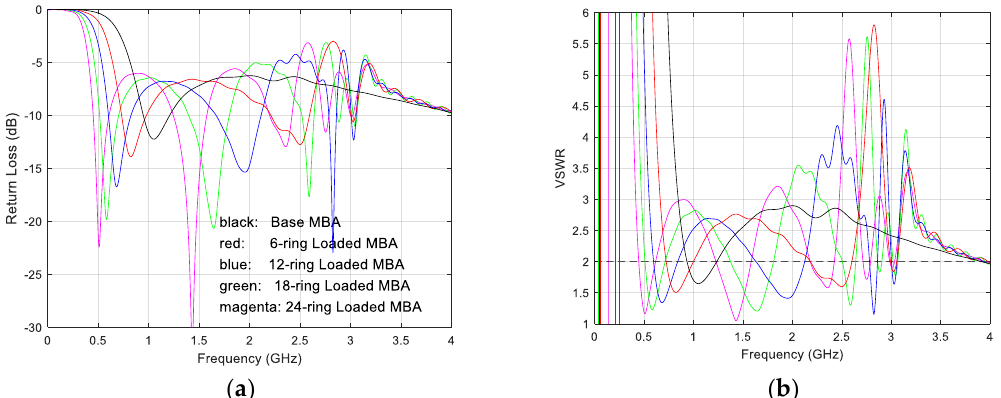
Figure 16. ( a ) Return loss and ( b ) VSWR of metallic-ring-loaded MBAs with an equal number of rings on both sides of the base MBA when the frequency is lower than 4 GHz.